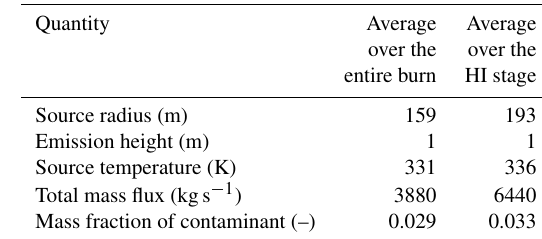
Table 3. Summary of the fire properties applied for the modeling of the base case and the case that uses input data measured during the high-intensity stage of the fire (the average values over both